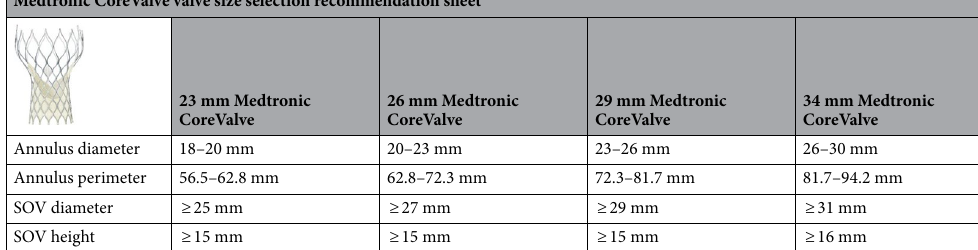
Medtronic CoreValve valve size selection recommendation